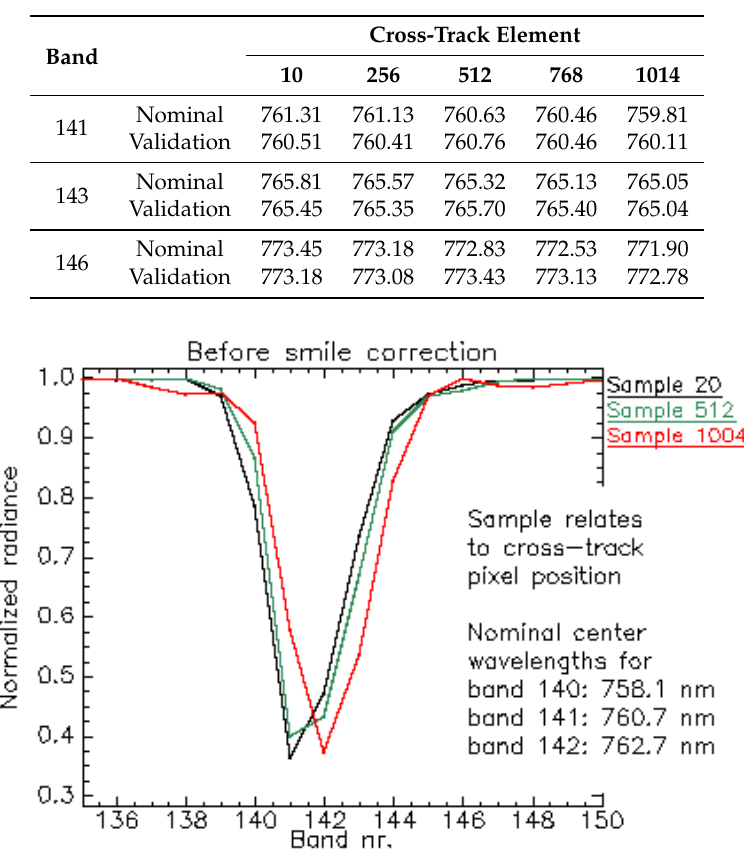
Figure 19. Example of the cross-track derivation of the Oxygen A absorption feature before smile correction.